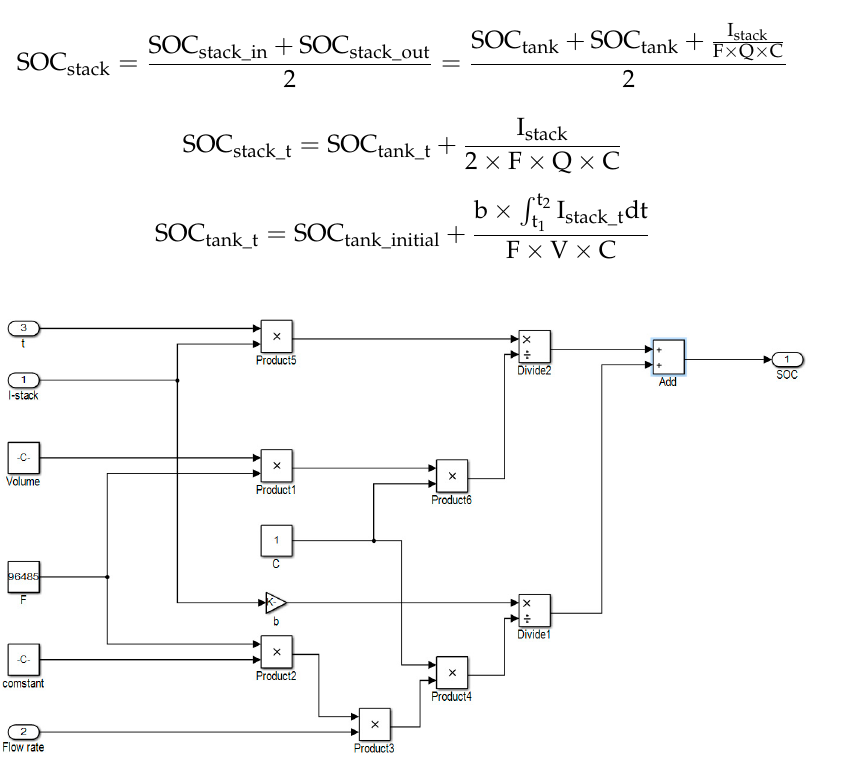
Figure 6. SOC estimation model of zinc–nickel single-flow battery stack. Table 3. Parameters [29–34].